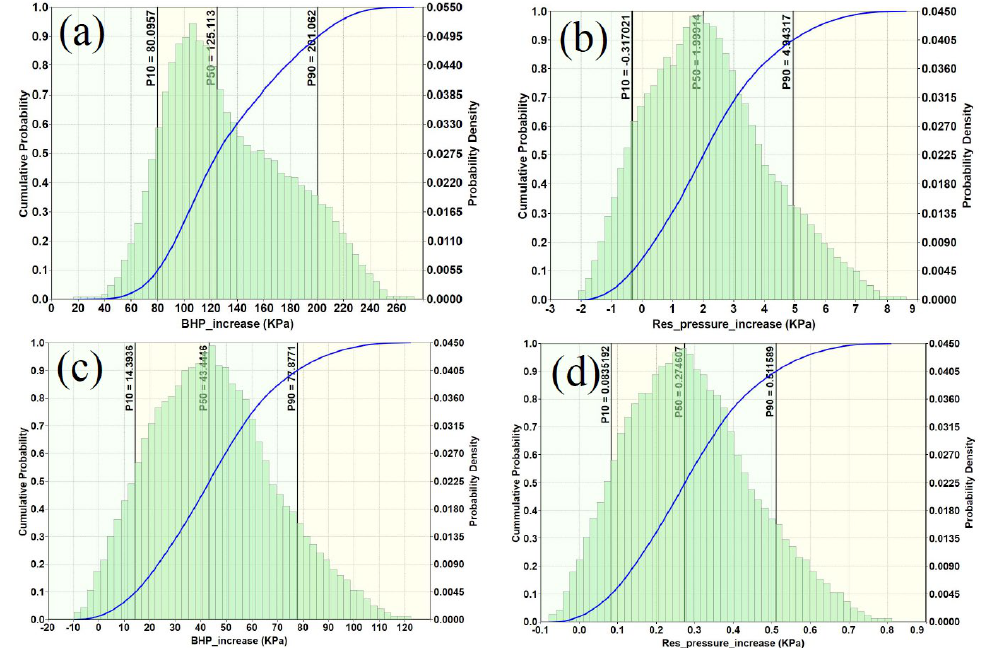
Figure 11. Uncertainty in the pressure buildup using 65,000 Monte Carlo simulation runs: ( a ) bot- tomhole pressure buildup for supercritical CO 2 injection, ( b ) average reservoir pressure buildup for supercritical CO 2 injection, ( c ) bottomhole pressure buildup for low-salinity water injection, and ( d ) average reservoir pressure buildup for low-salinity water injection.